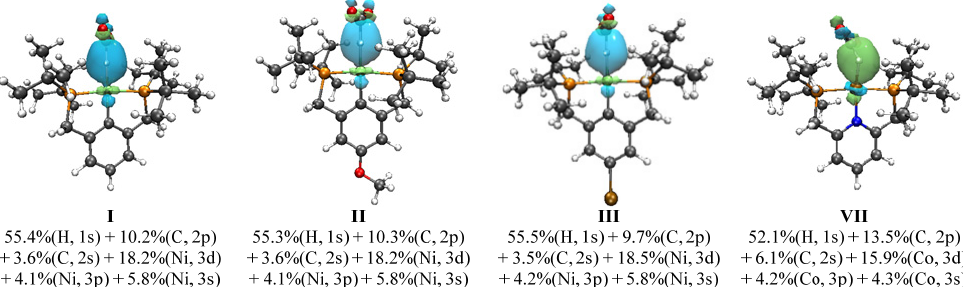
Figure 5. The natural adaptive orbitals (NAdOs) with their eigenvalues for the TM-H-C interaction in the TM-(H)-formate complexes I , II , III, and VII . Only the first NAdOs with the isovalue of 0.05 are presented in the main text.